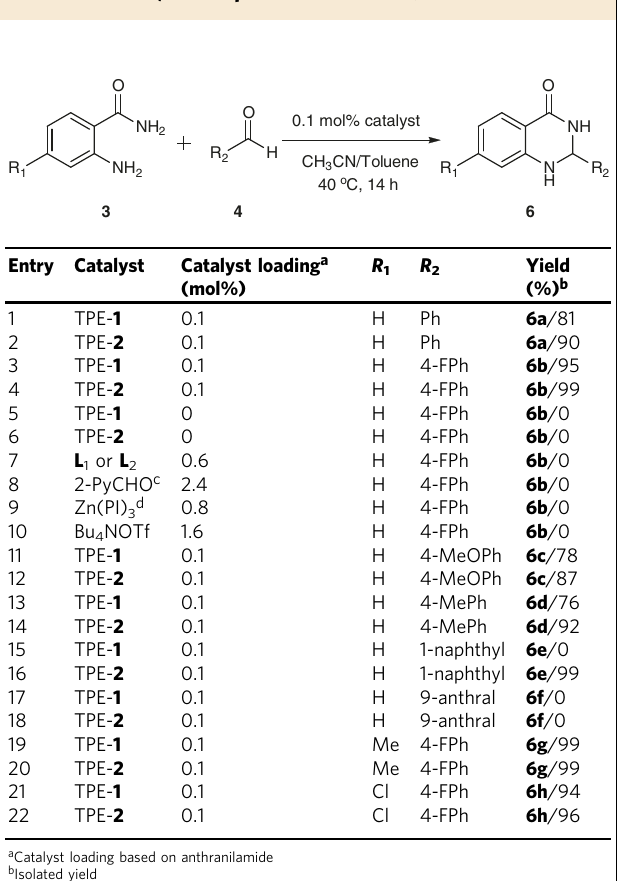
Table 1 Sequential condensation and cyclization of anthranilamide with aldehydes catalyzed by the cages (for reaction details, see Experimental